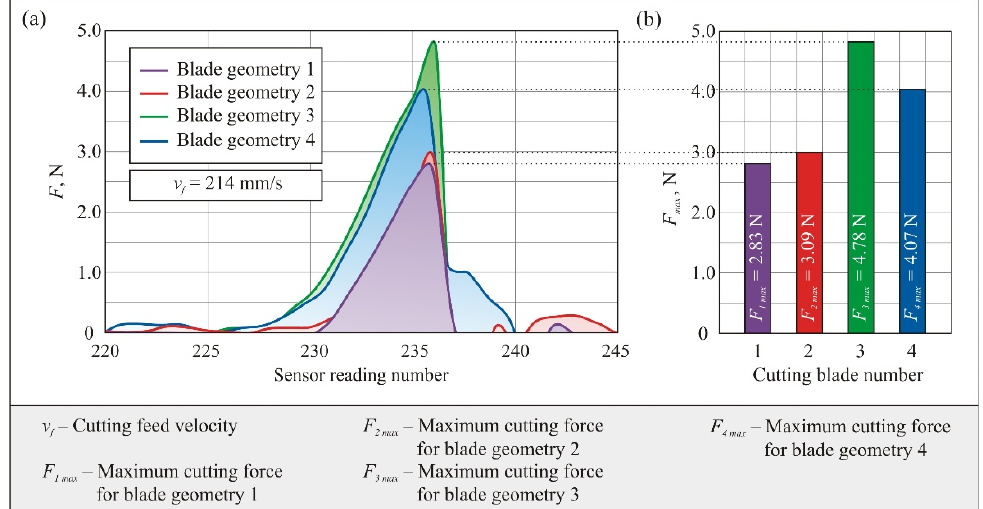
Figure 7. Summary of recorded plots of cutting force F for the four blade geometries evaluated—tests with maximum F values for each blade ( a ) and plot of maximum force values F max ( b ).